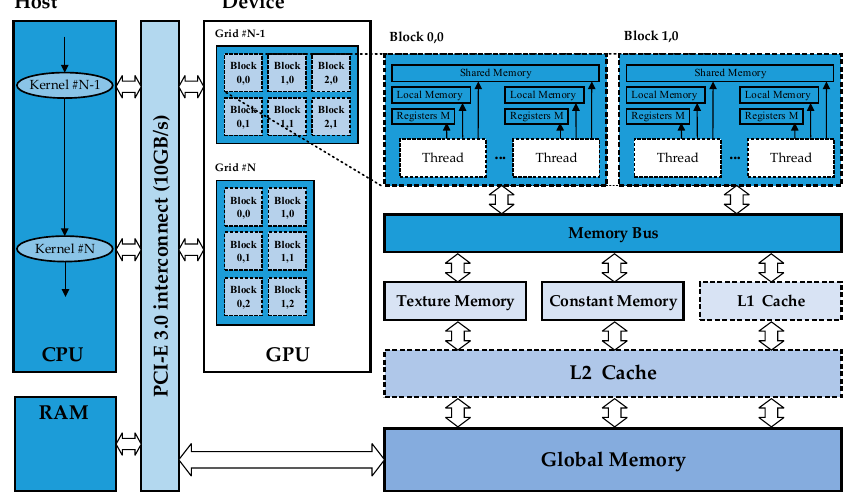
Figure 5. The architecture and operation of NVIDIA GPU, and the data transfer between CPU and GPU.